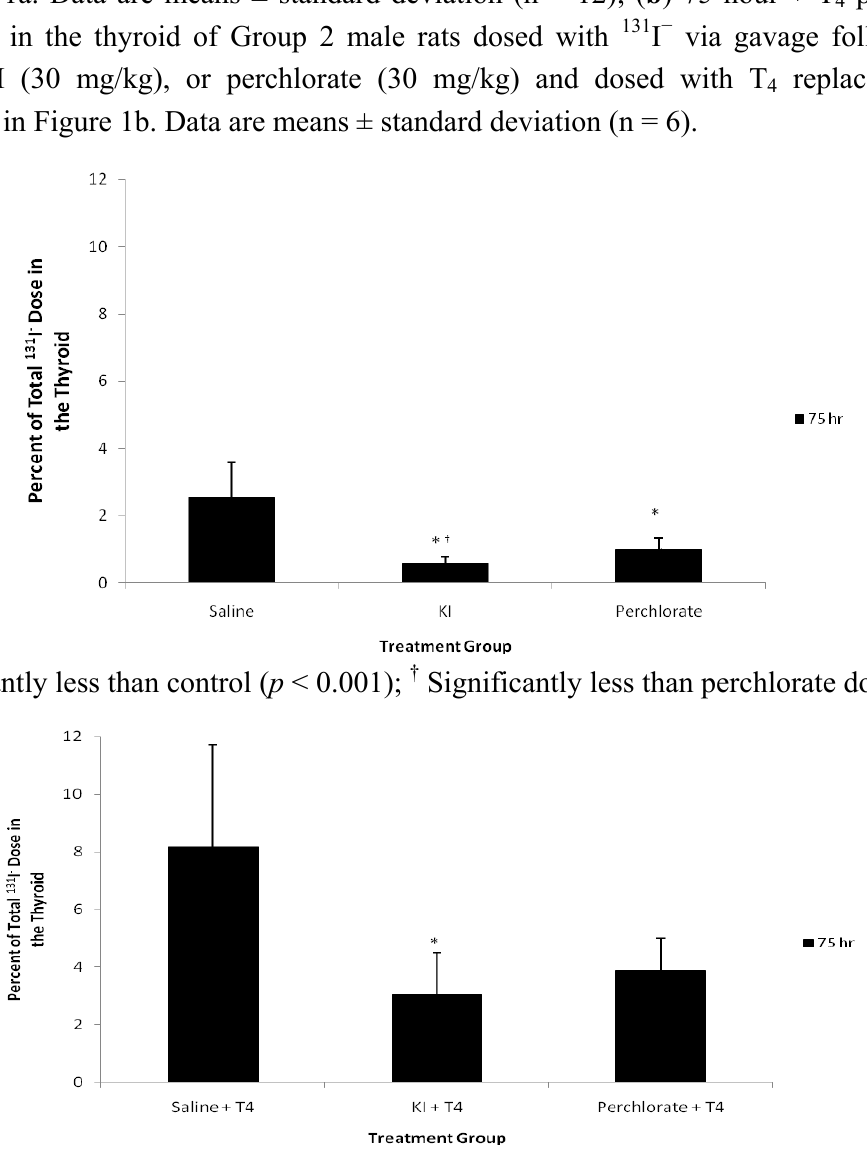
percent of 4 replacement as 4